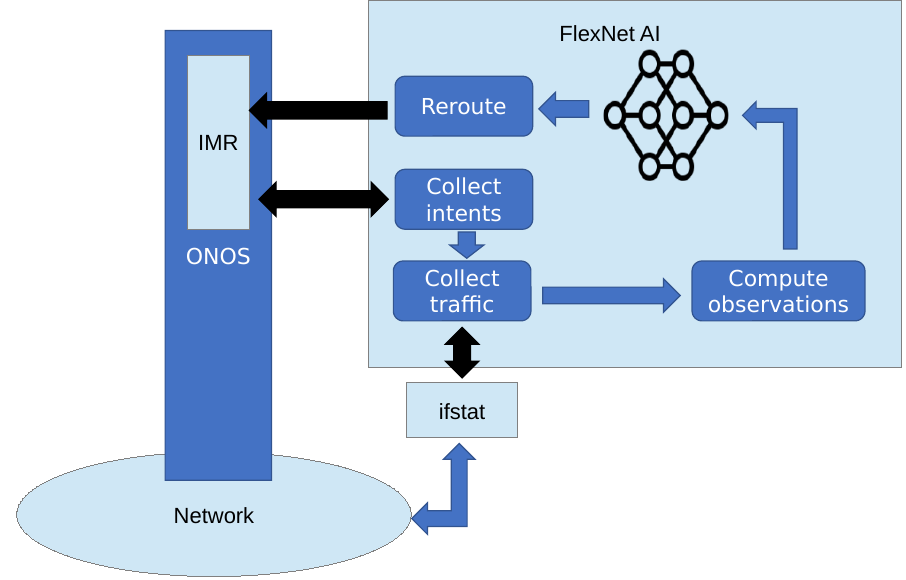
Figure 1. Conceptual model of the